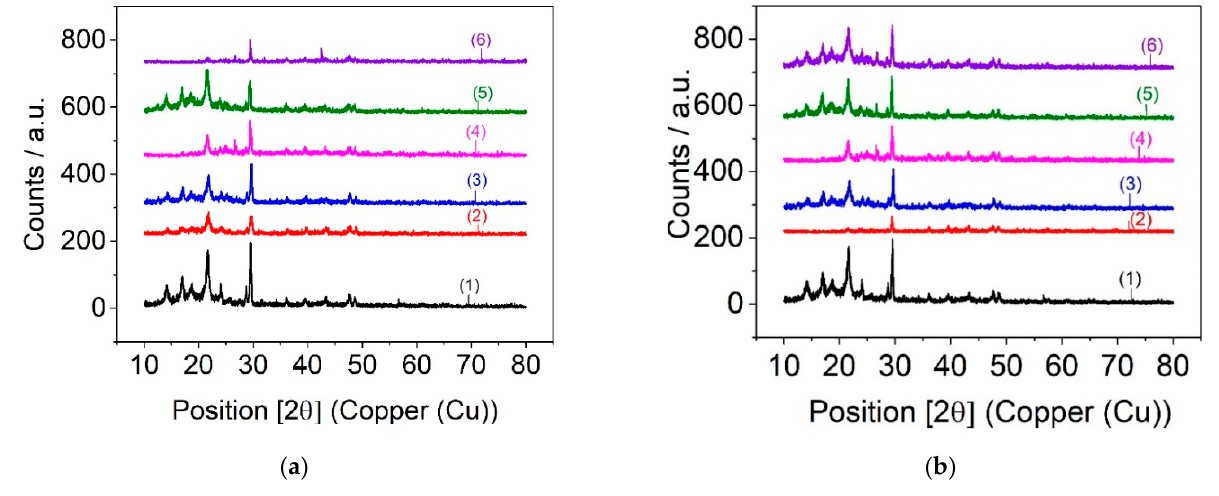
Figure 8. XRD patterns of PPW (1), PPW/SBSBC (2), PPW/n-Clay 5% (3), PPW/n-Clay 10% (4), PPW/SBSBC/n-Clay 5% (5), and PPW/SBSBC/n-Clay 10% (6) samples ( a ) and PPW (1), PPW/SISBC (2), PWP/n-Clay 5% (3), PPW/n-Clay 10% (4), PPW/SISBC/n-Clay 5% (5), PPW/SISBC/n-Clay 10%